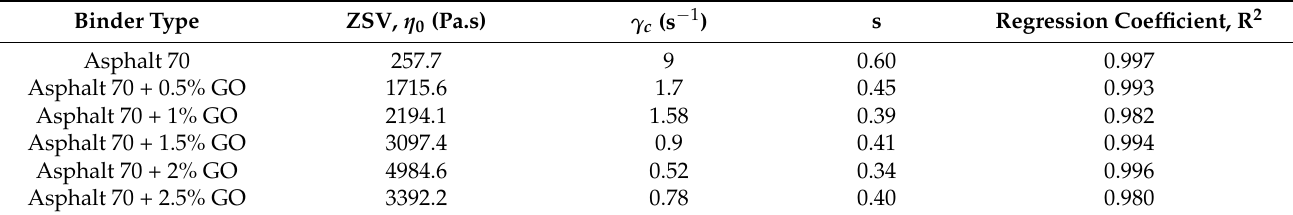
Figure 4. Carreau model fitted curves for GO-modified binders. Table 2. Carreau model parameters for GO-modified